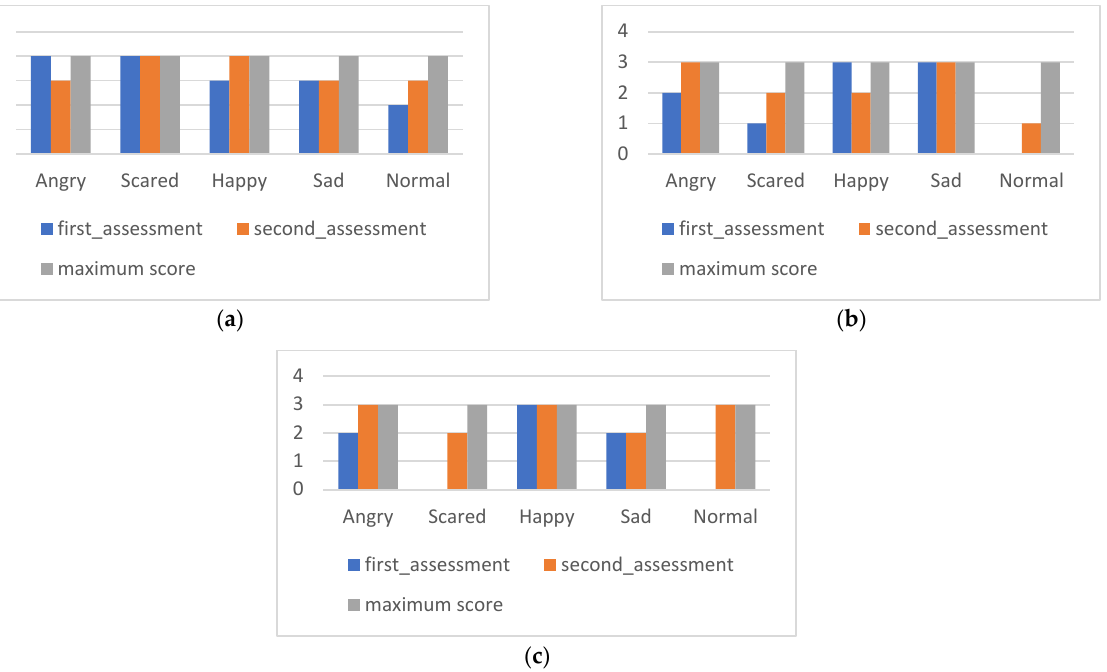
Figure 5. Tomás’s ACES subscales : ( a ) facial expressions; ( b ) situations; ( c ) behavior. Figure 5. Tom á s’s ACES subscales: ( a ) facial expressions; ( b ) situations; ( c )